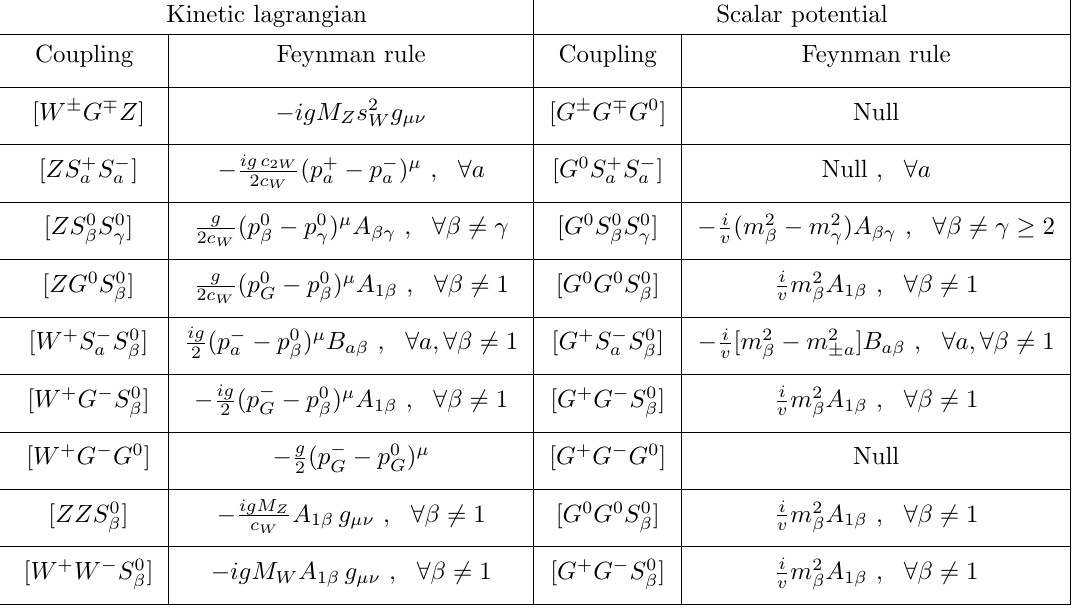
Table 2 . All cubic couplings from the kinetic lagrangian (except photon) and their scalar potential counterparts obtained by substituting all gauge bosons by the corresponding Goldstone